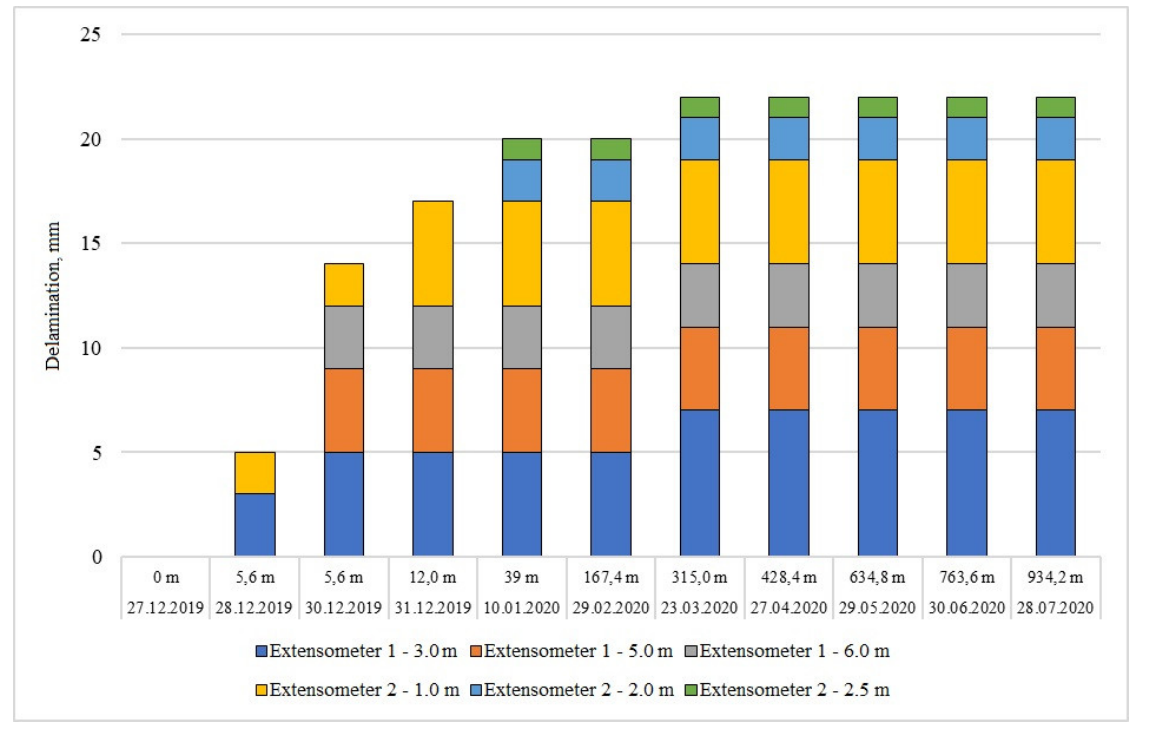
Figure A2. Roof delaminations measured using multilevel mechanical extensometer—periodic control station no. 3.